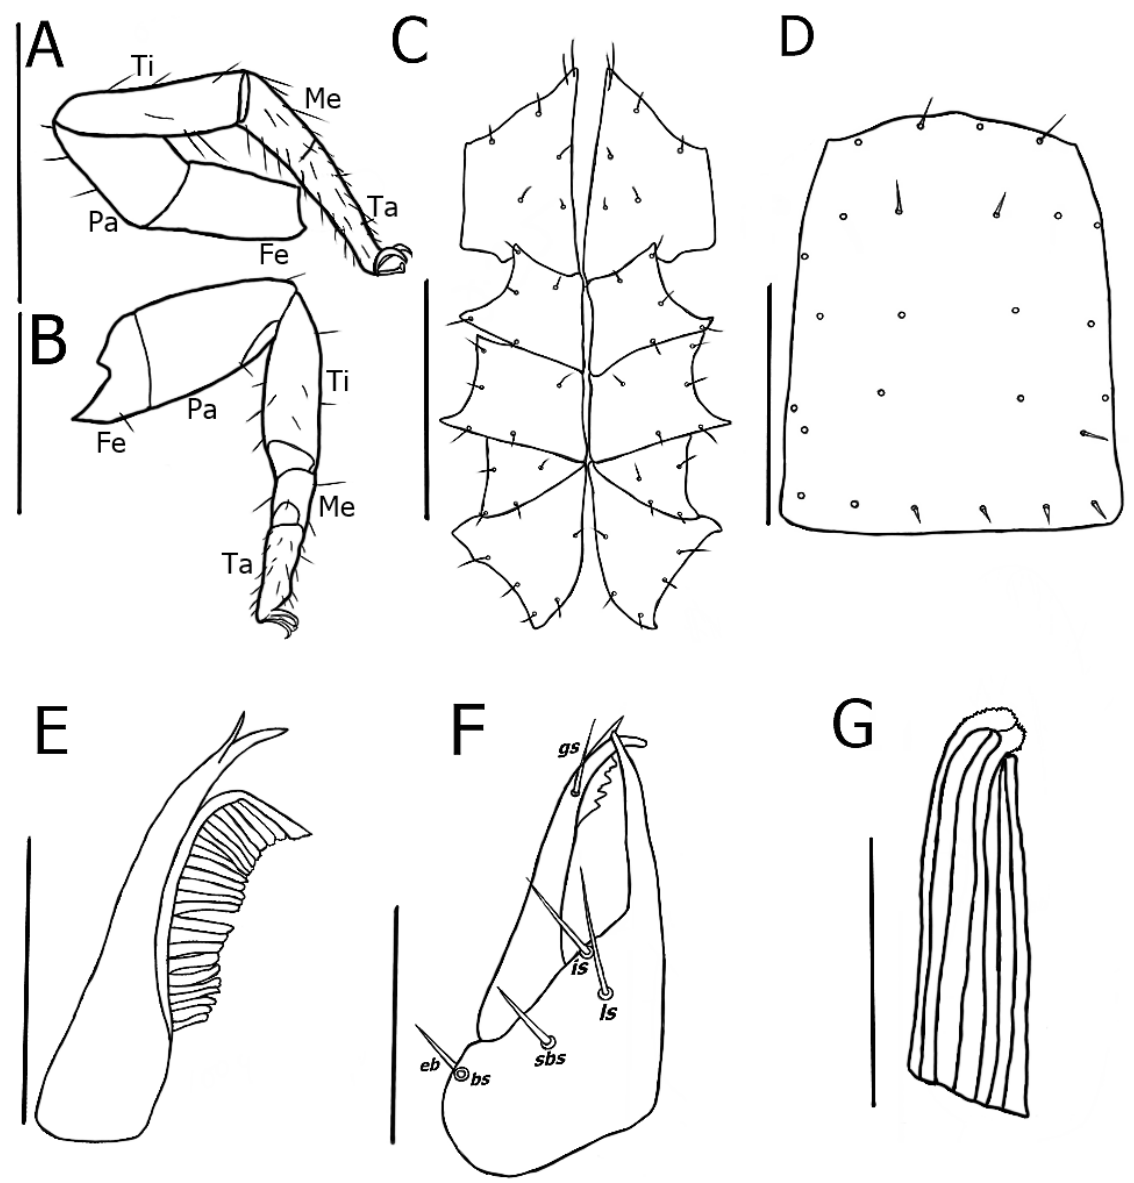
Fig. 23. Ideoblothrus nadineae sp. nov., holotype, ♂ (QCAZ). A . Leg I. B . Leg IV. C . Coxa. D . Carapace. E . Serrula exterior. F . Chelicera in dorsal view, showing trichobothria. G . Rallum. Abbreviations: Fe = femur; Pa = patella; Ti = tibia; Me = metatarsus; Ta = tarsus. Scale bars: A–D = 0.25 mm; E = 100 µm; F = 0.125 mm; G = 20